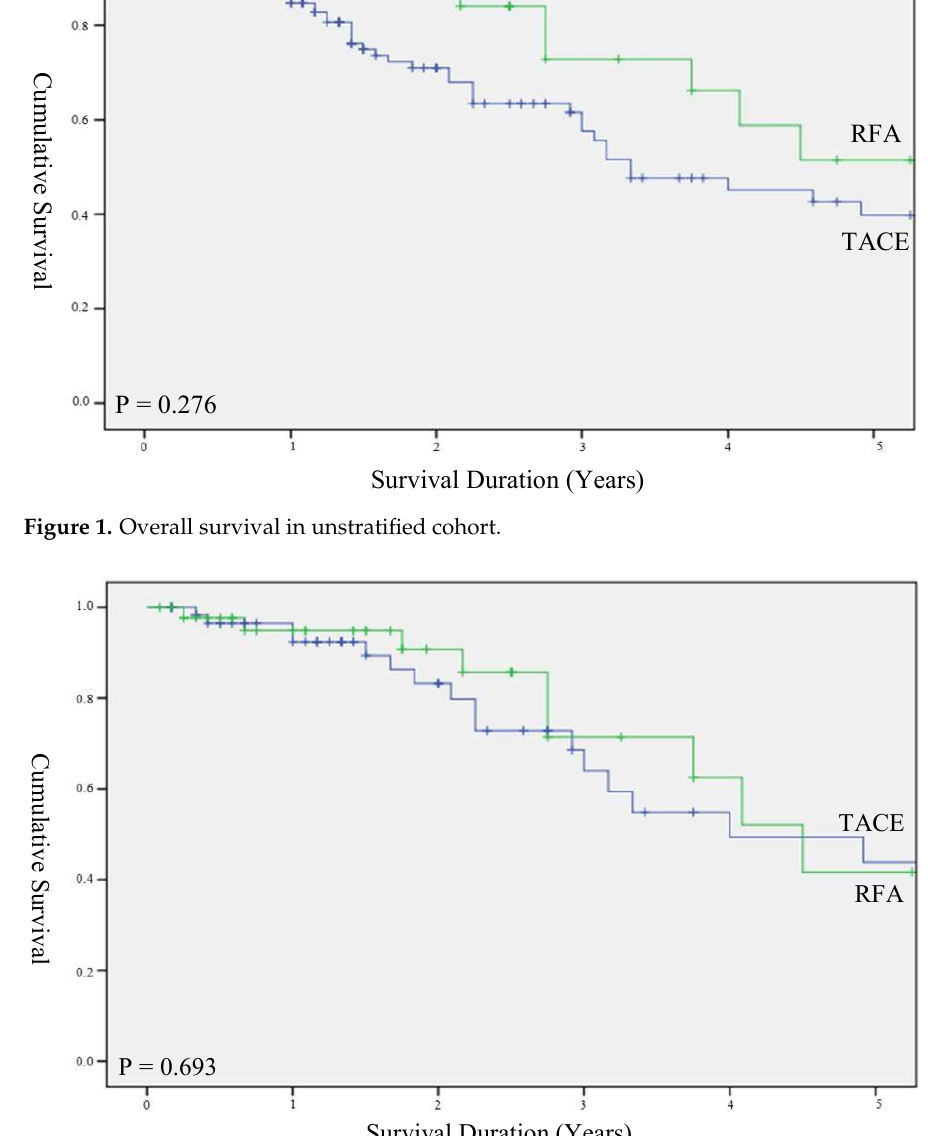
Figure 2. Survival duration stratified for HCC < 3 Fig. 2 Survival duration stratified for HCC < 3cm